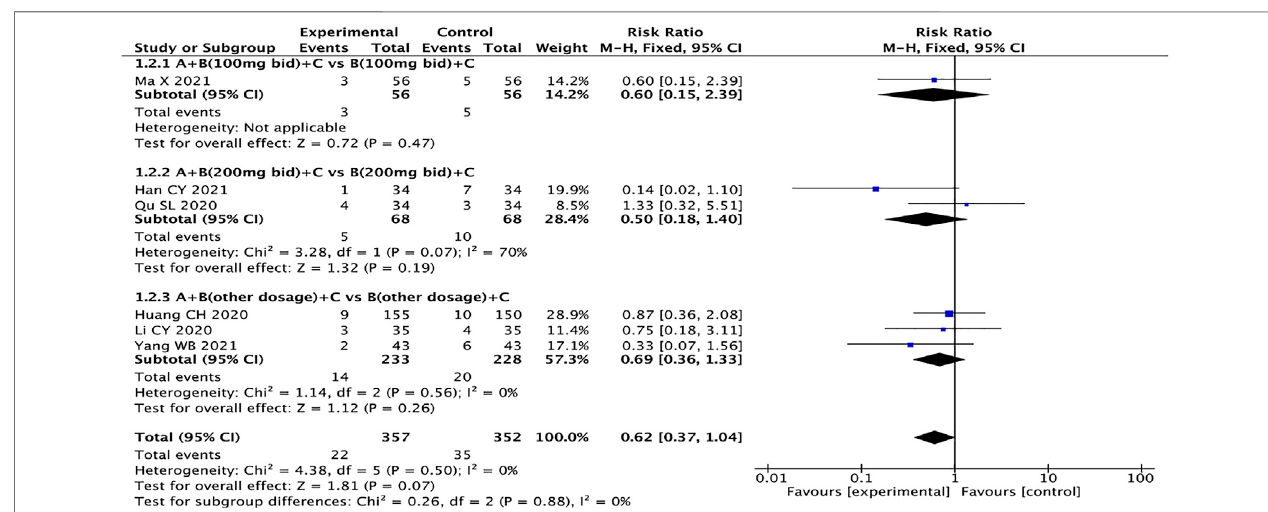
FIGURE 11 | Forest plot of adverse